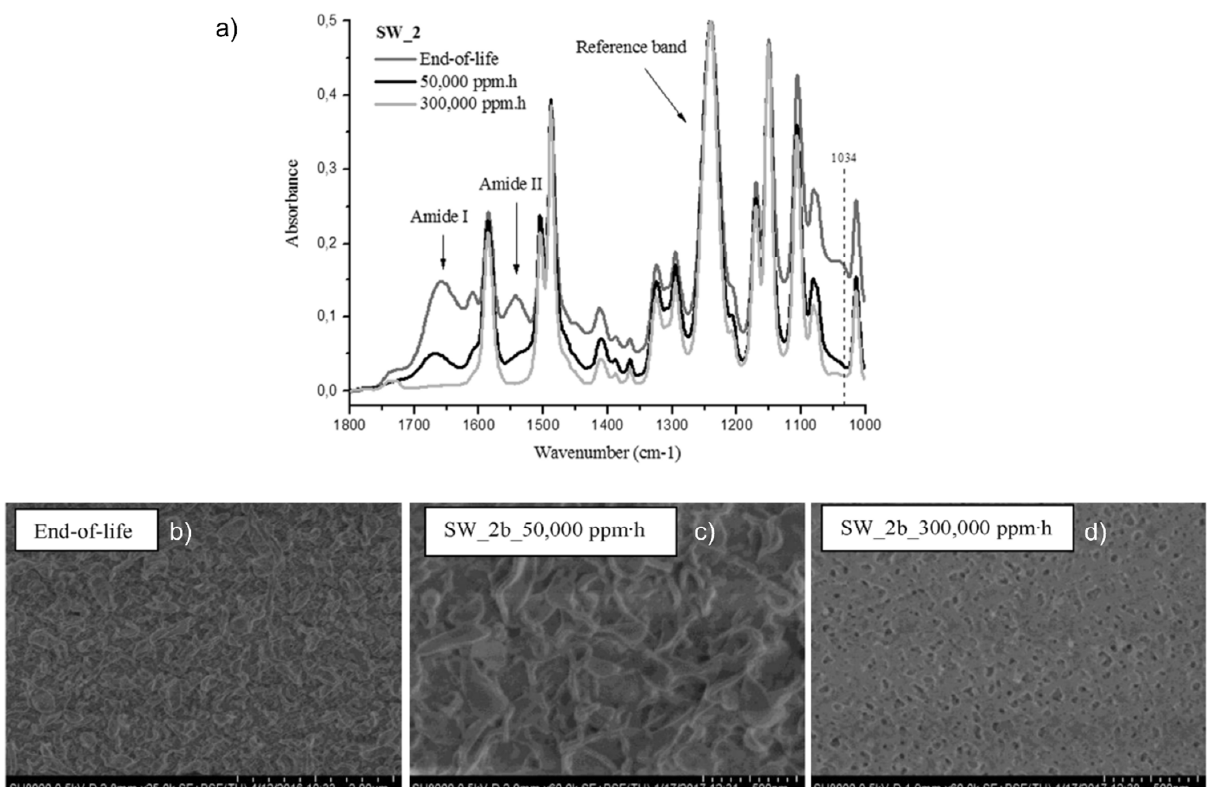
Figure 8. Surface characterisation by ( a ) ATR-FTIR of EoL RO SWRO membrane and recycled NF and UF-like membranes (50,000 ppm h and 300,000 ppm h exposure doses to NaClO, respectively). Surface morphology by SEM, ( b ) EoL SWRO membrane, ( c ) recycled NF-like membrane with remaining PA (after 50,000 ppm h exposure dose to NaClO; and ( d ) recycled UF-like membrane with the porous PSF surface (after an exposure dose of 300,000 ppm h to NaClO). Reproduced with permission from Ref. [119]. Copyright 2018, S. Molina et al.